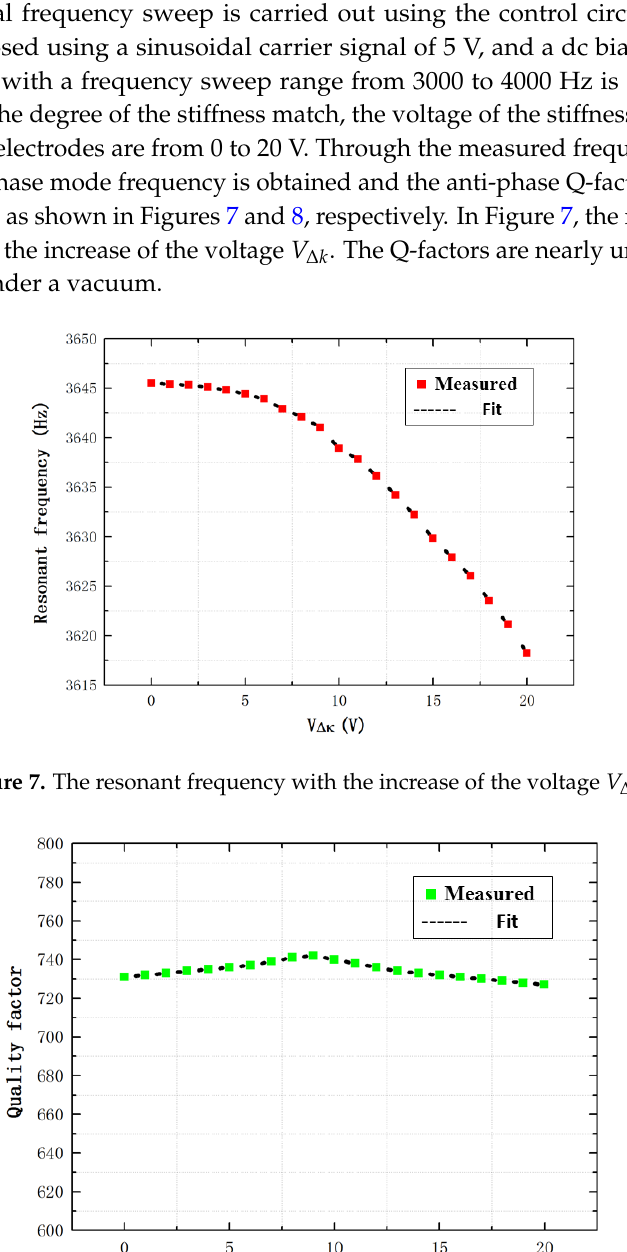
Figure 6. The experimental setup.